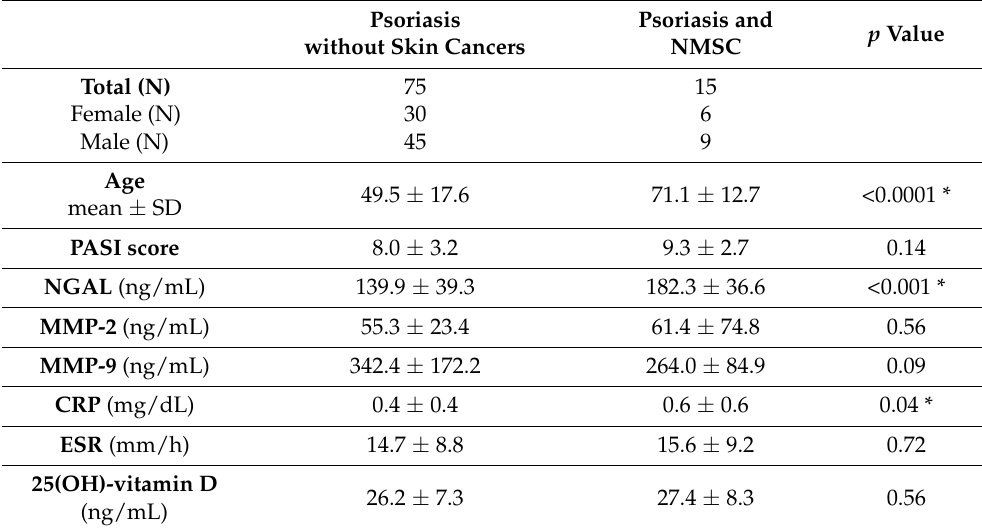
Table 5. Patients with psoriasis without skin cancers vs. patients with psoriasis and NMSC.